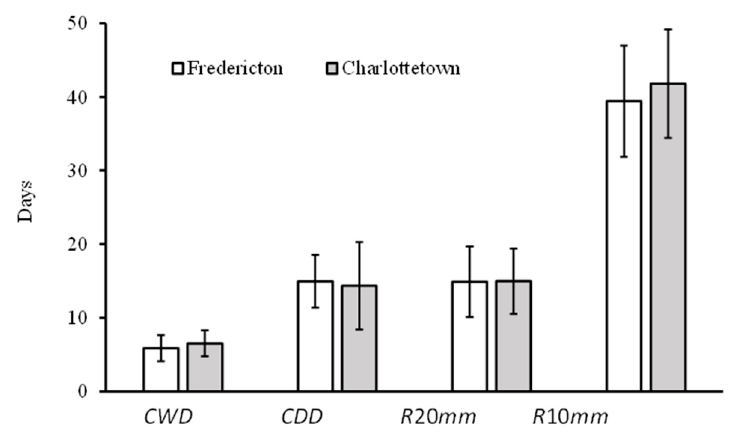
Figure 2. The mean number of days for consecutive wet, consecutive dry, very heavy precipitation, and heavy precipitation with their overlapping standard deviation bars reflecting no statistically significant difference between the annual means of the mentioned indices of Fredericton (open columns) and Charlottetown (shaded columns).